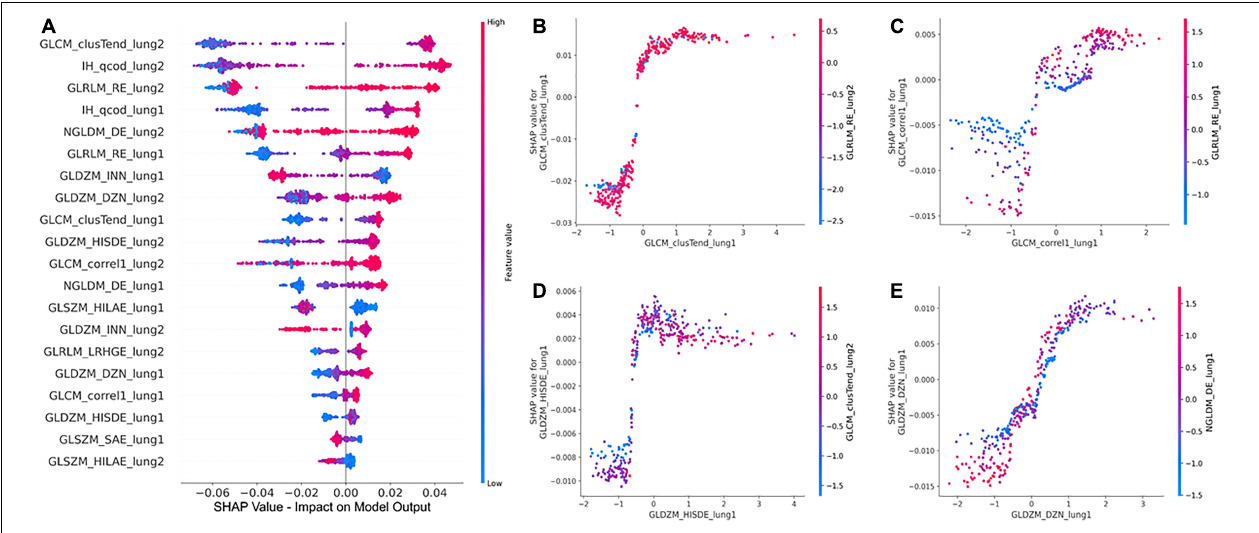
FIGURE 5 | Global SHAP summary plots (A) demonstrate the impact of the top 20 features on the model output in terms of SHAP values and the corresponding feature values. SHAP dependence plots (B–D) , and (E) show the effect of a particular feature value on the SHAP value and its interaction with another